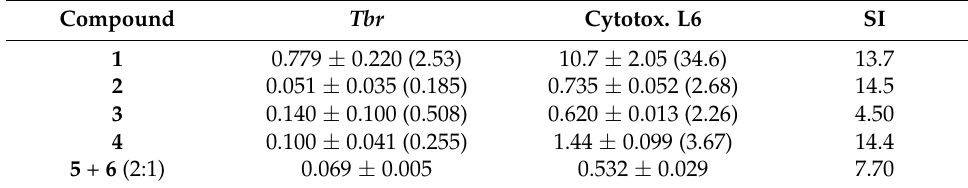
Table 3. In vitro anti-trypanosomal and cytotoxic IC 50 values in µg/mL (values in µM of pure compounds are reported in brackets) of elemanolides 1 – 6 . For positive controls, see Table 1.